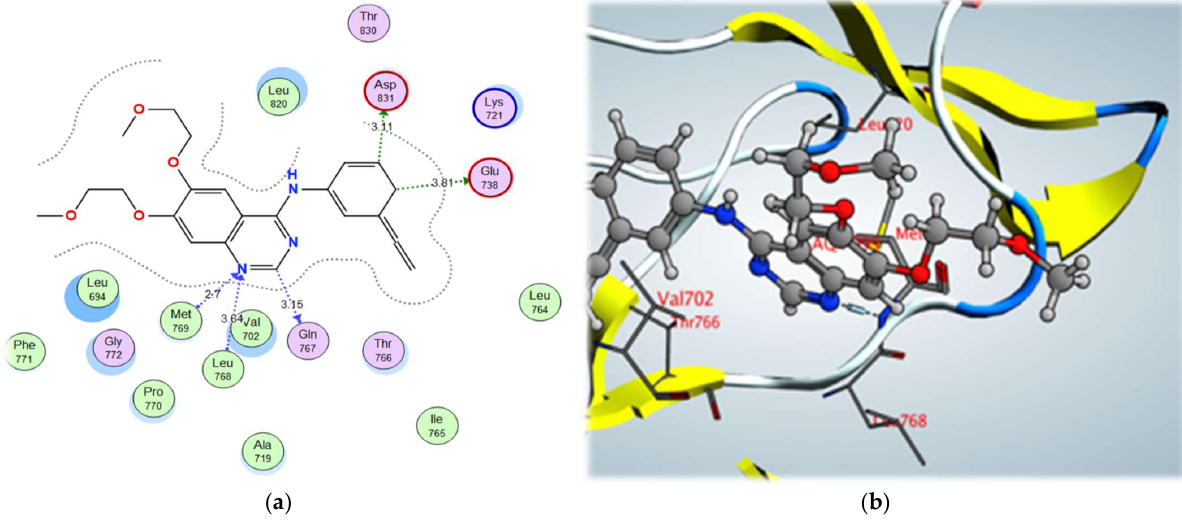
Figure 6. ( a ) 2D interactions and ( b ) 3D interactions of erlotinib within the EGFR kinase domain’s active site.